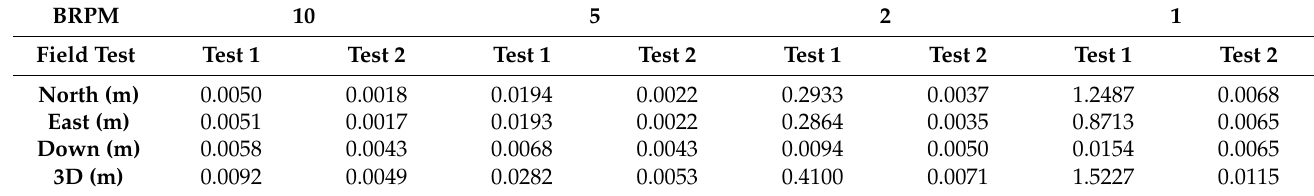
Table 1. RMSE of predictions of position increments.